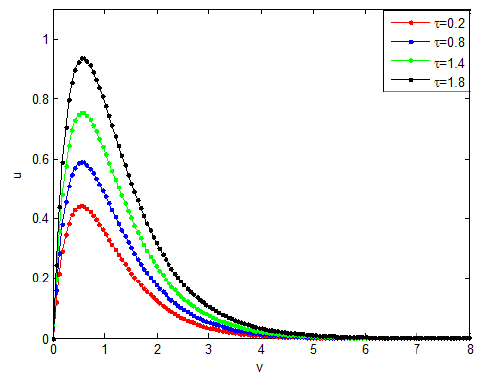
Figure 22. Effects of flow time on the velocity